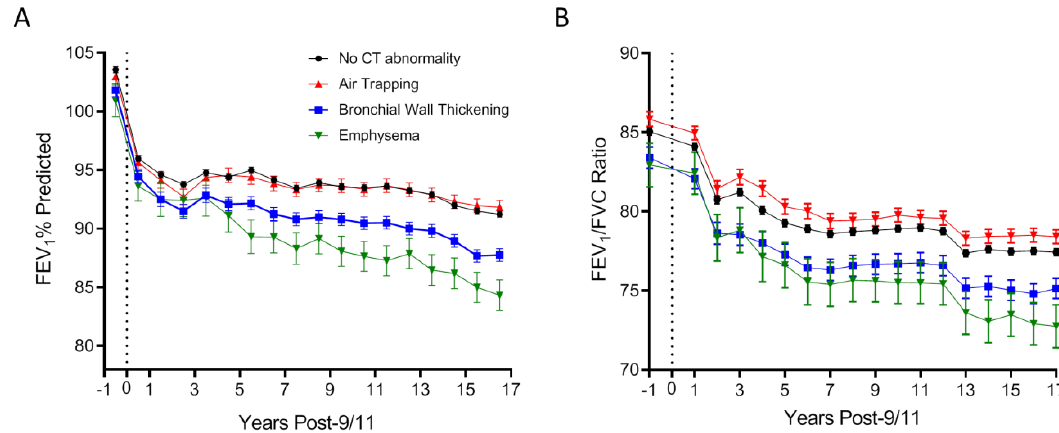
Figure 4. Longitudinal lung function according to CT abnormality. ( A ) shows mean FEV 1 % predicted ( ± SEM) in each year between 11 / 9 / 2000 and 10 / 9 / 2018 in the no chest CT diagnosis (black circles), isolated air trapping (blue triangles), isolated bronchial wall thickening (brown squares), and isolated emphysema (red inverted triangle) groups. ( B ) shows mean ( ± SEM) FEV 1 / FVC ratio in each year in the aforementioned groups, adjusted for age, race and height. Number of subjects in each nonoverlapping group is shown. The vertical line at 0 represents 11 / 9 / 2001.